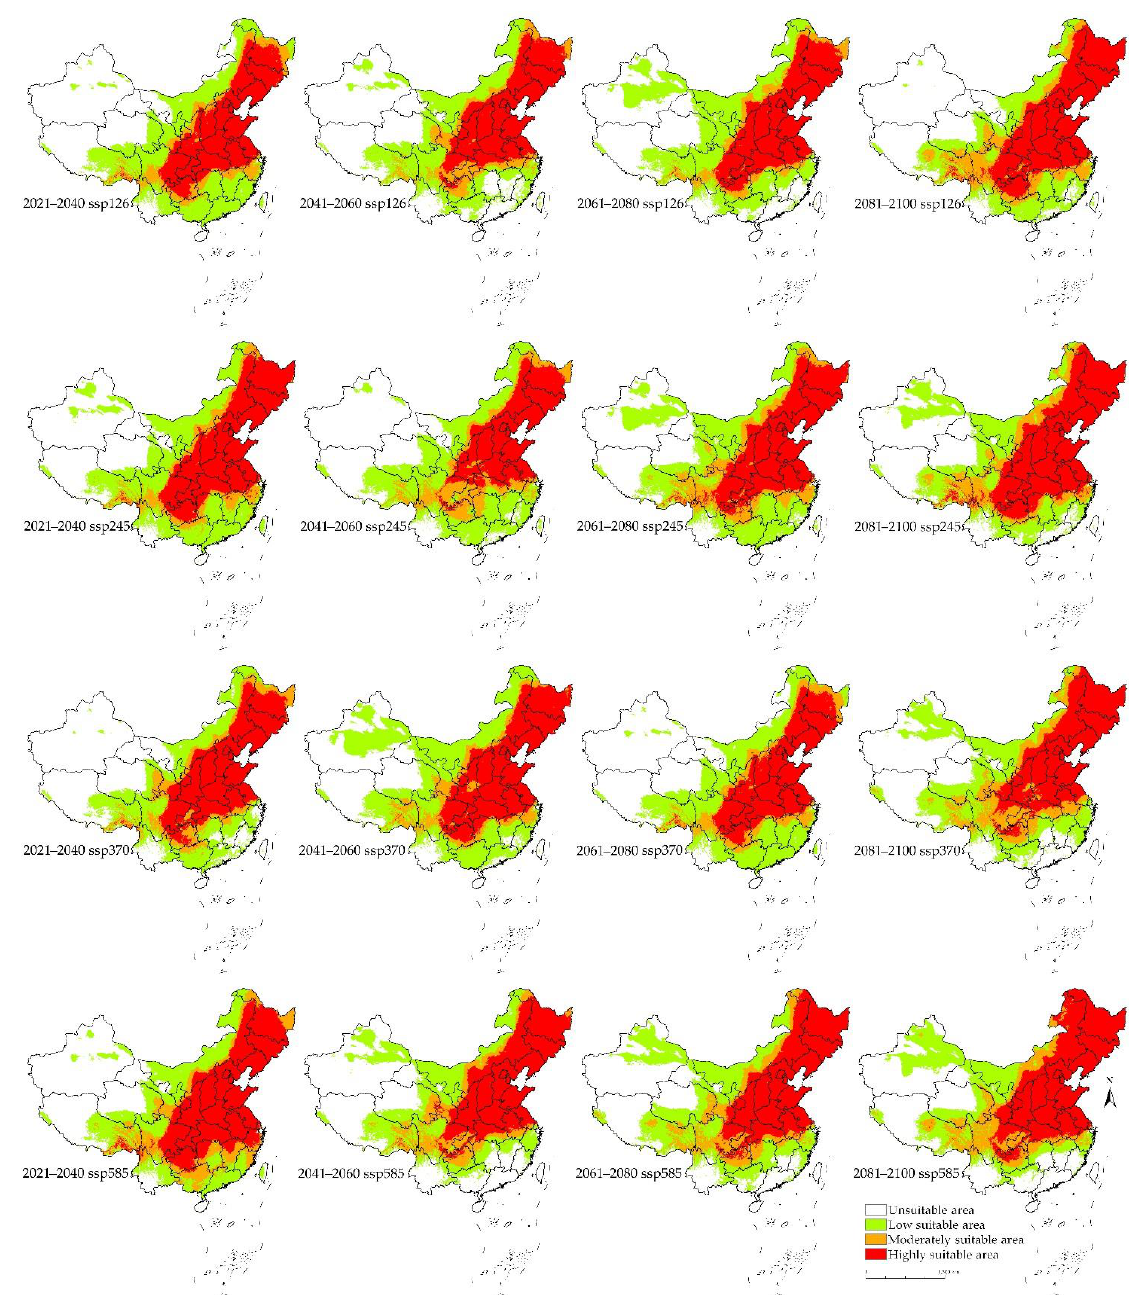
Figure 6. Predicted potential distribution of S. nitobei in China under the future climate conditions during the periods of the 21st century under four Coupled Model Intercomparison Project Phase 6 (CMIP6) climate scenarios, and including four shared socio-economic pathways (ssp126, ssp245, ssp370, and ssp585).